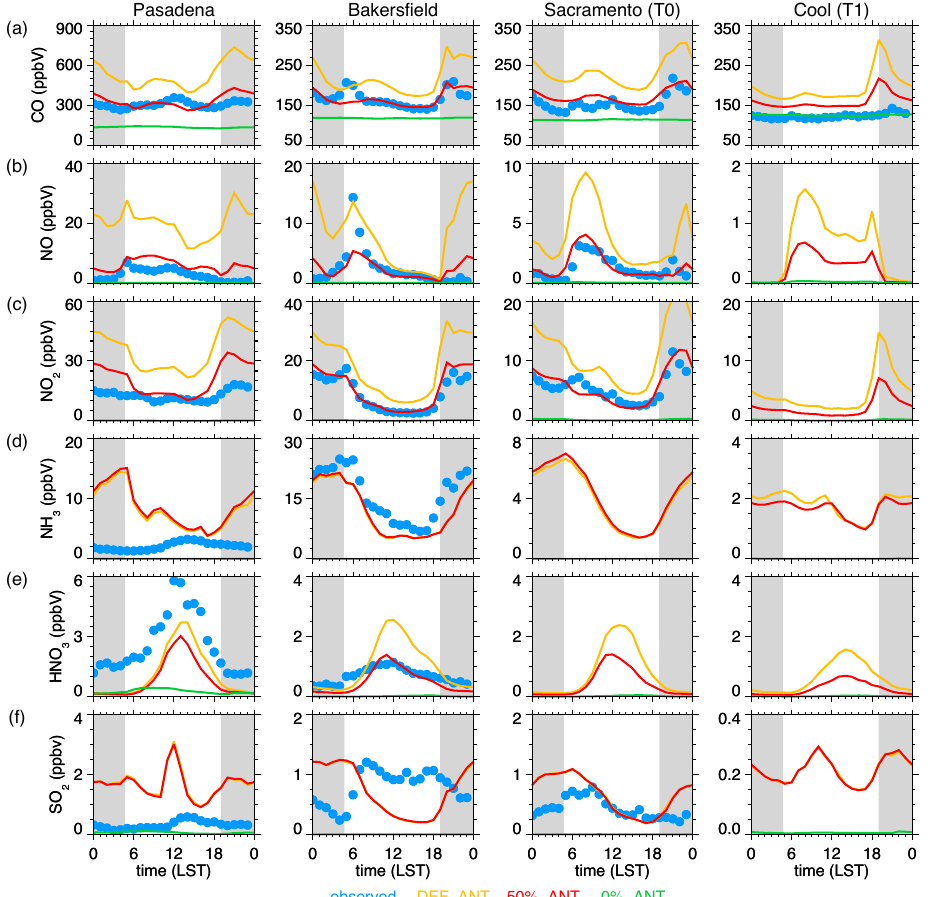
Figure 3. Observed and simulated diurnally averaged (a) carbon monoxide (CO), (b) nitrogen oxide (NO), (c) nitrogen dioxide (NO 2 ) , (d) ammonia (NH 3 ) , (e) nitric acid (HNO 3 ) , and (f) sulfur dioxide (SO 2 ) over the 2-month period at the Pasadena, Bakersfield, T0, and T1 supersites. Gray shading denotes night. Missing observations indicate measurements were not collected at a particular site. 50%_LBC simulation results not shown since they are nearly identical to those from the 50%_ANT